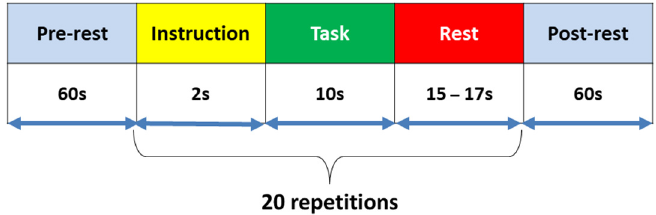
Figure 1. Experimental paradigm for data acquisition. After the initial 60-s rest, a single trial consisted of a 2-s visual instruction period, then 10 s left motor imagery (LMI), right motor imagery (RMI), motor imagery (MI), and mental arithmetic (MA) tasks followed by a 15–17 s